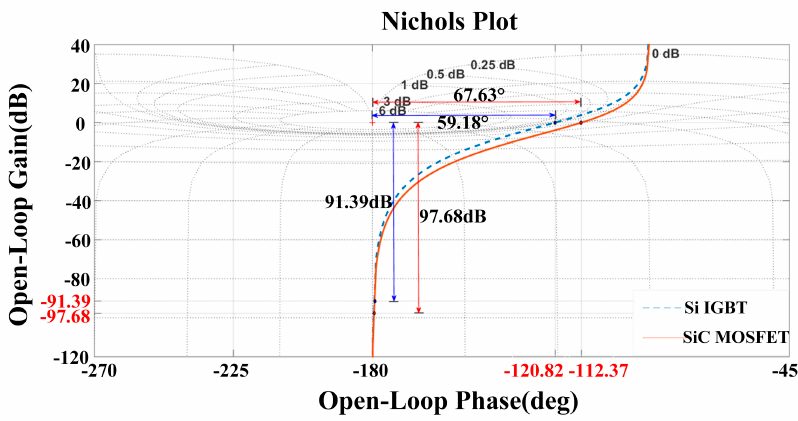
Figure 8. Nichols plot of the inverter fed PMSM system with different power devices.